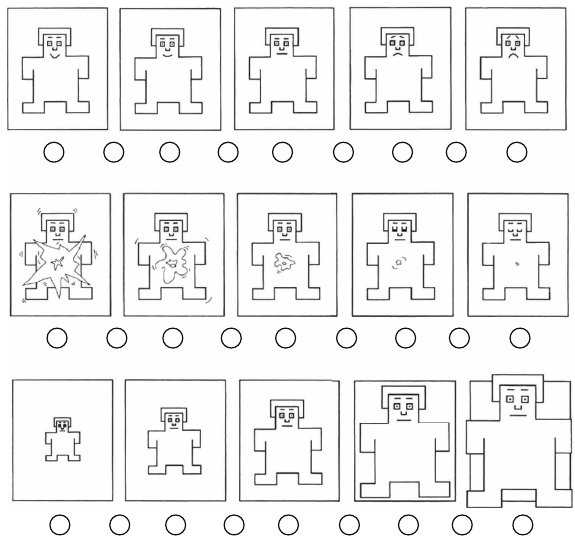
Figure 2: Manikins in the 9-point scale SAM test for the “Pleasure” (first row), “Arousal” (second row), and “Dominance” (third row)